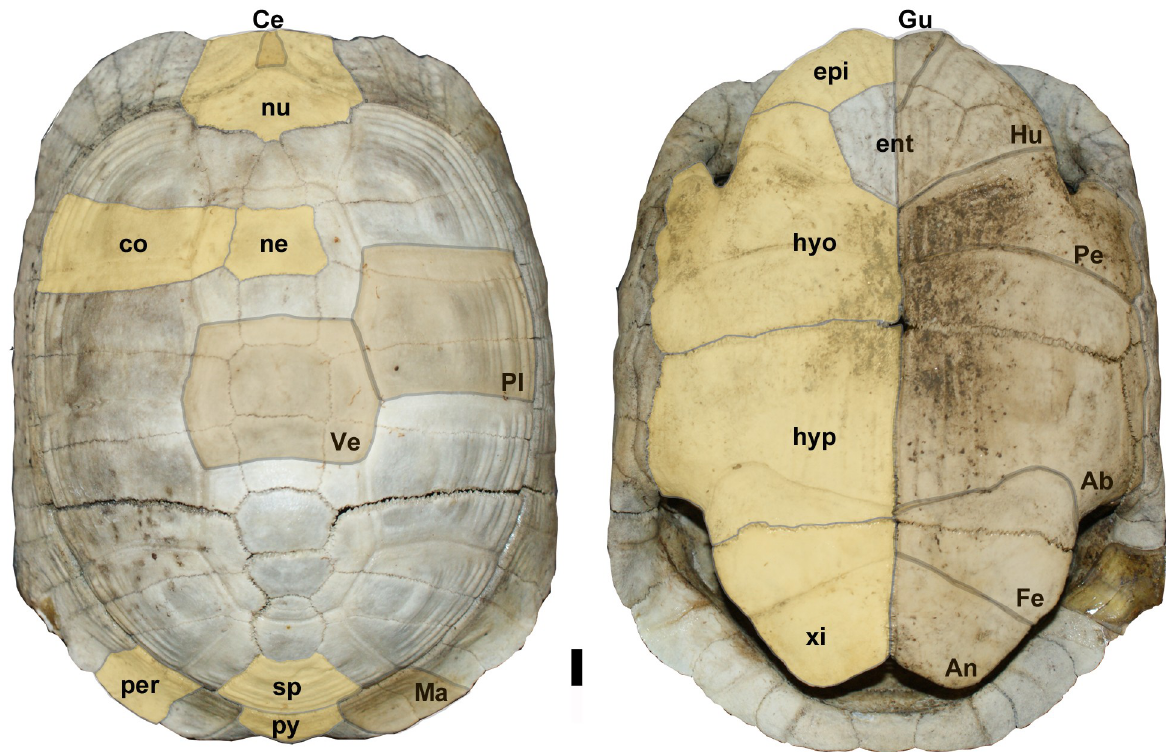
Fig 1. Extant Testudo graeca (UP-2015-05) from Greece. nu: nuchal; ne: neural; co: costal; sp: suprapygal; py: pygal; per: peripherals; epi: epiplastron; ent: entoplastron; hyo: hyoplastron; hyp: hypoplastron; xi: xiphiplastron. Scutes: Ce: cervical; Pl: pleural; Ma: marginal, Ve: vertebral; Gu: gular; Hu: humeral; Pe: pectoral; Ab: abdominal; Fe: femoral; An: anal.